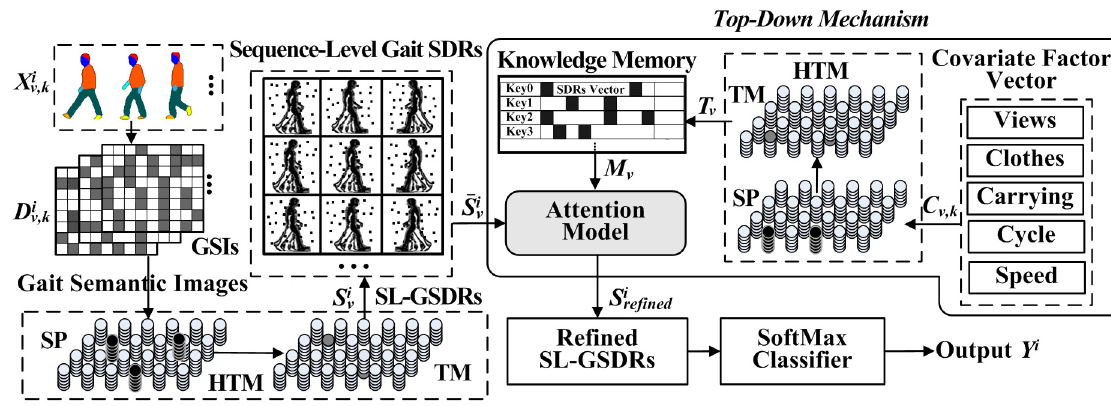
Figure 8. Framework of the sequence learning network.